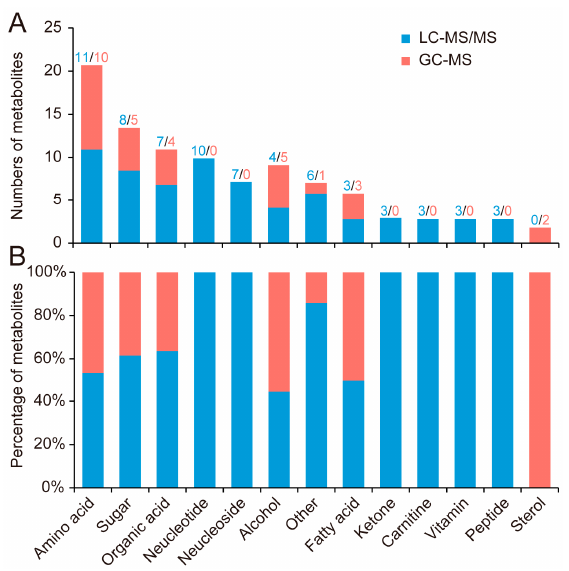
Figure 2. Classification of the identified metabolites. ( A ) The numbers of metabolites identified by GC-MS or LC-MS/MS; ( B ) The percentage of metabolites identified by GC-MS and LC-MS/MS. Nucleosides, nucleotides, ketones, carnitines, vitamins, and peptides were only identified by